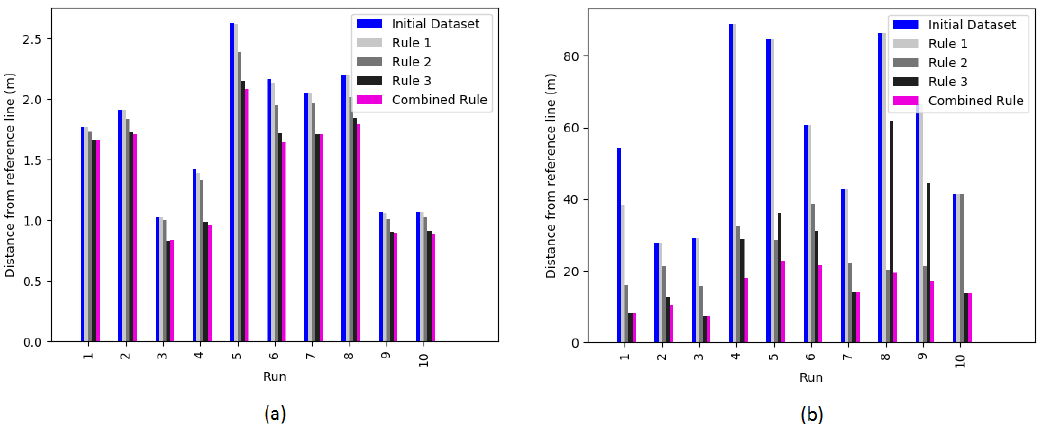
Figure 4. ( a ) Mean and ( b ) Maximum distance of the GNSS points from the reference track while applying the